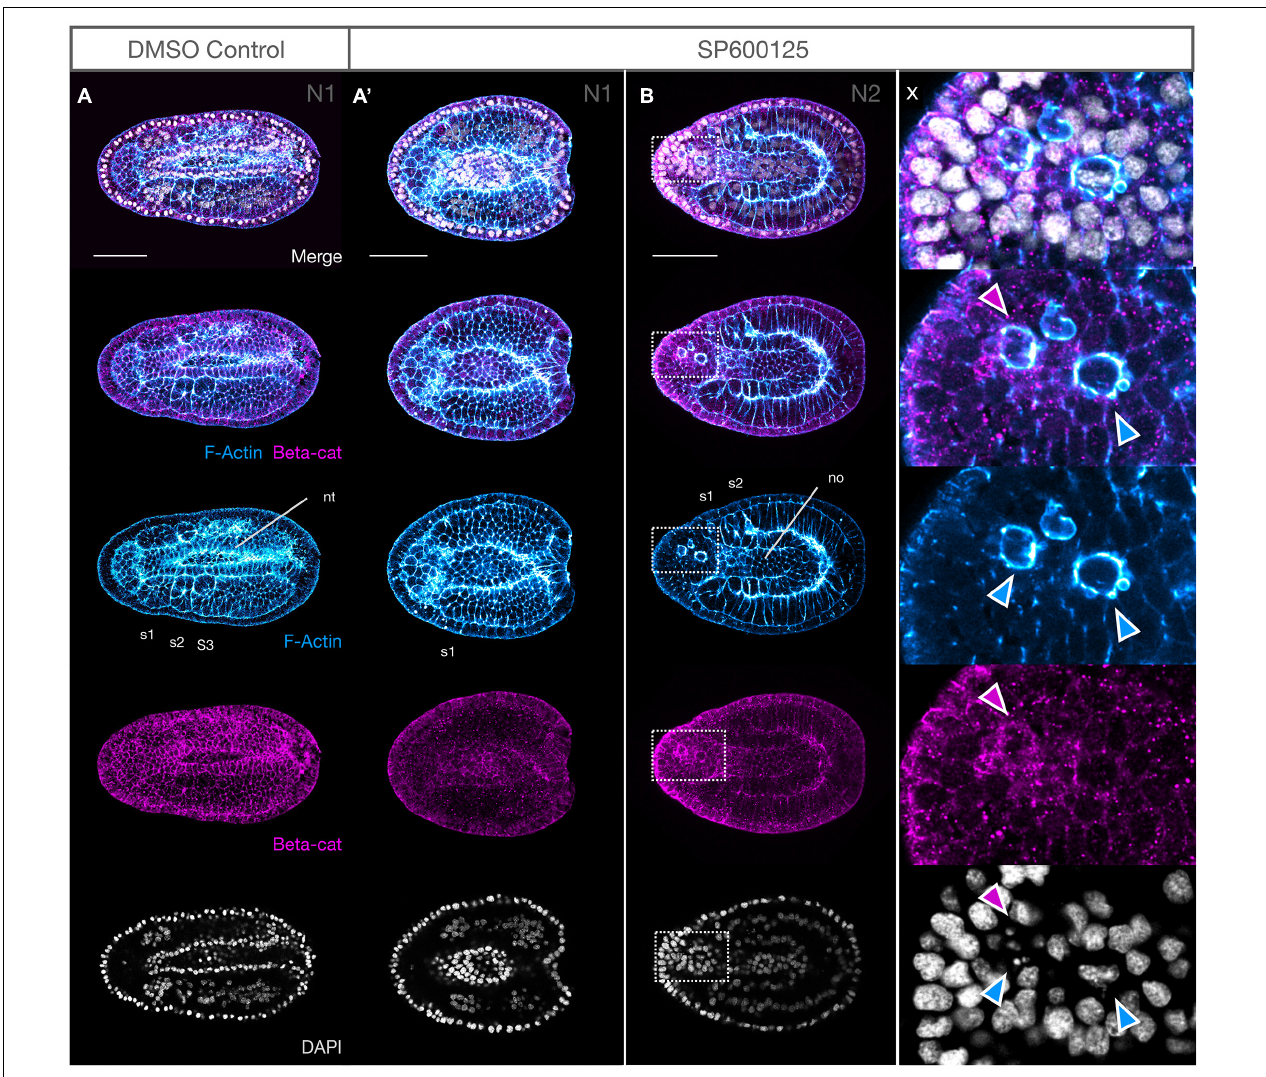
FIGURE 6 | Notochord cells round up, accumulate F-Actin and β -catenin at the membranes and undergo nuclear breakdown after JNK inhibition. (A,A (cid:48) ) At N1, the membranes of DMSO controls contain F-Actin and β -catenin, with three pairs of somites clearly outlined. The neural tube is almost entirely closed, and notochord cells can be seen anteriorly and below (A) . SP600125-treated embryos are delayed, with only the first somite demarcated. β -Catenin is patchily distributed but outlines notochord cells, particularly their irregular apical membranes anteriorly (A (cid:48) ) . (B) By N2, some notochord cells have rounded up, with strong F-Actin staining in the membranes and accumulation of β -catenin (magenta arrowheads in inset x). These cells have numerous blebs (blue arrowheads) and DAPI-stained nuclei are irregular or pycnotic (inset x). All embryos are orientated anterior to the left, with dorsal views shown. Representative embryos are shown. F-Actin and β -catenin labelled membranes are in blue and magenta, respectively, and DAPI stains nuclei in grey. nt, neural tube; no, notochord; s1, s2, etc., numbered somites. Scale bars = 50 µ